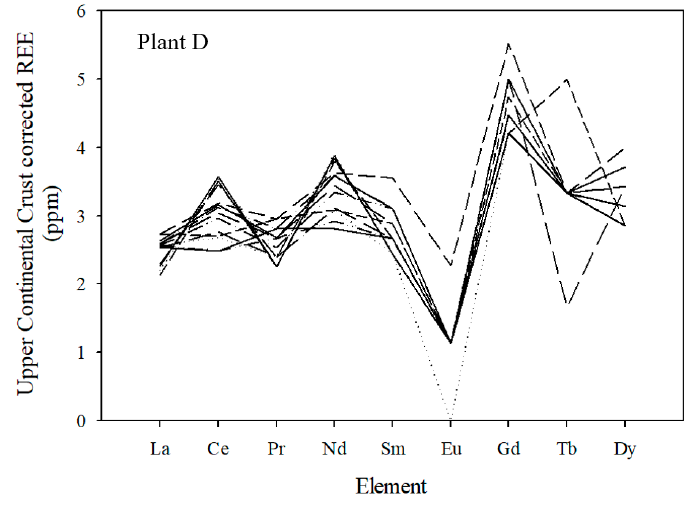
Figure 7. CaO and SO 3 concentrations for the <200-mesh products of consecutive runs of the Plant D and I fly ashes. Note, except for the first five runs for Plant D, the numbers do not correspond to the run numbers in Table 3.